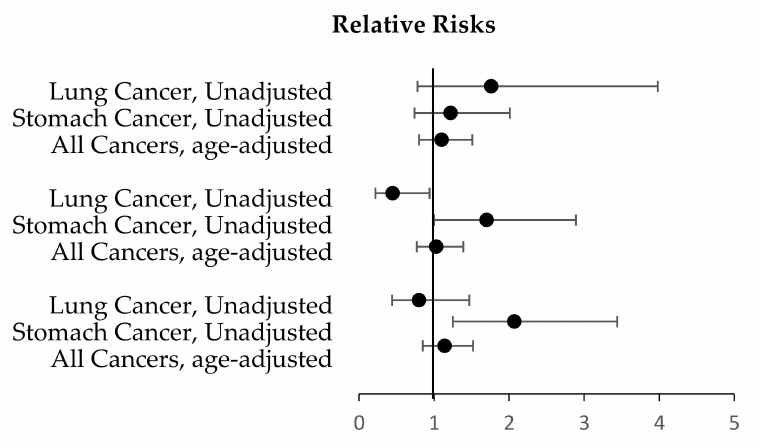
Figure 3. Forest plot with Relative Risks for comparisons of the cancer death rates in an industrial town (Group A), three agricultural villages (Group B), and five agricultural villages (Group C) for each group (RR). An RR = 1.0 indicates identical risk among the two groups. An RR > 1.0 indicates an increased risk for the group in the numerator. An RR < 1.0 indicates a decreased risk for the exposed